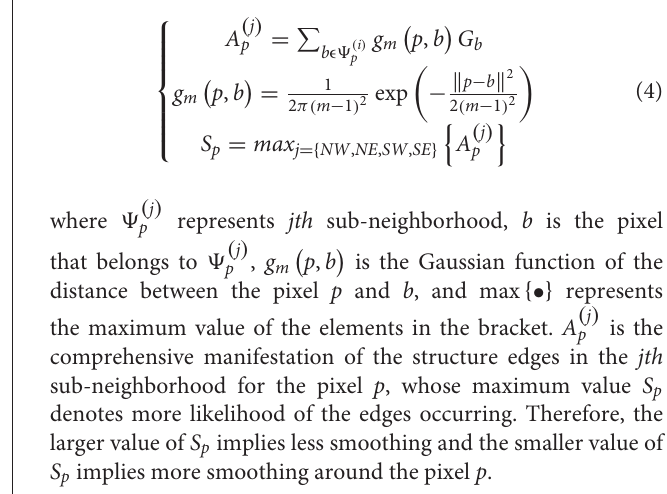
FIGURE 2 | Sub-neighborhoods of four direction for structure